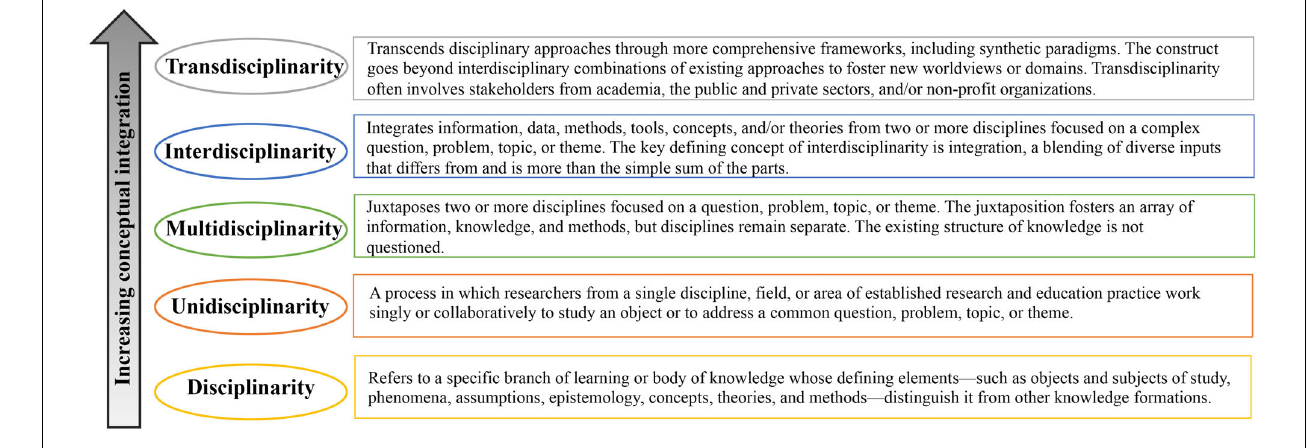
FIGURE 2 | Conceptual degrees of disciplinary